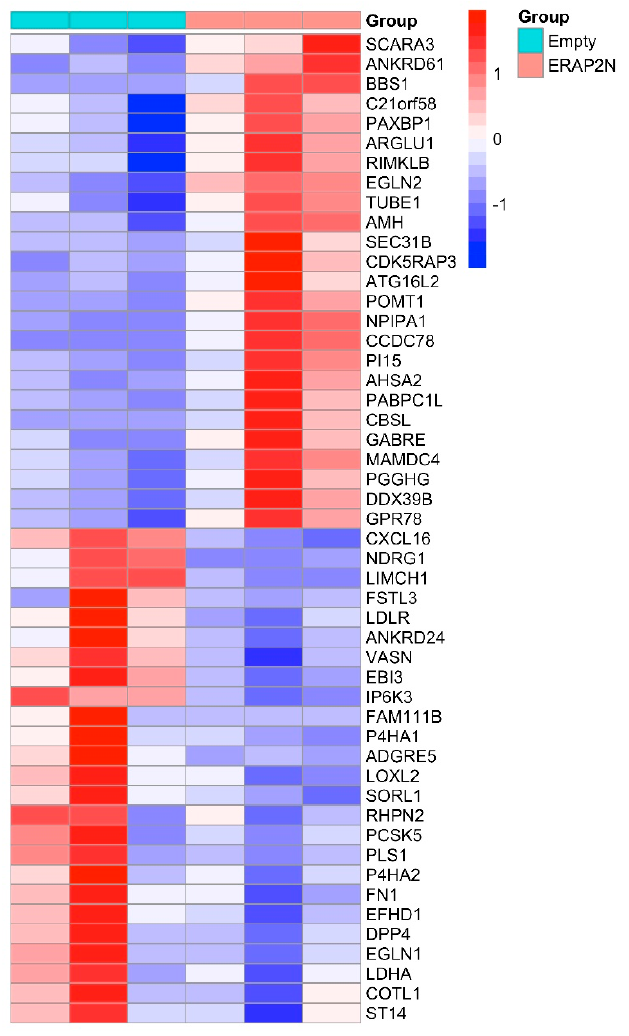
Figure 2. A heatmap of the top 50 most significantly differentially expressed genes (DEGs) in ERAP2N-positive vs. ERAP2N-negative trophoblast cells. The first three columns represent the cells transfected with an empty vector (no ERAP2N), and the last three columns represent ERAP2N-expressing trophoblast cells (TCs). Row-scaled log2-transformed TPMs (TPM = transcript count per million) are shown (N = 3/each group).